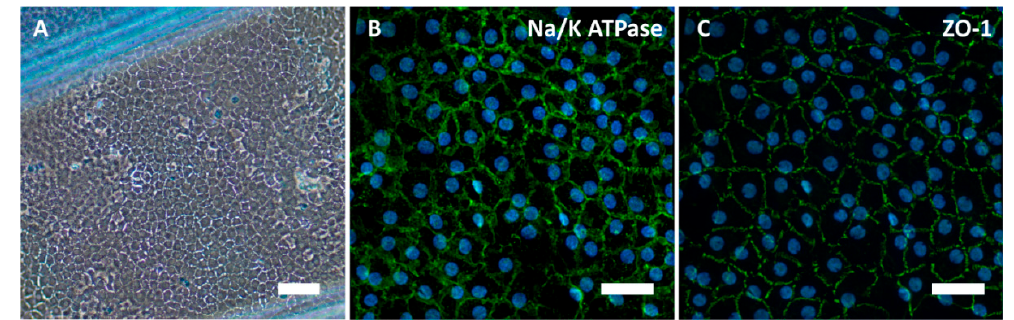
Figure 2. Human corneal endothelium biopsy analysis. Brightfield image of the typical hexagonal morphological pattern exhibited by human corneal endothelial cells (hCECs) ( A ); immunofluorescence analysis of native human corneal endothelium ( B and C ); cell nuclei were stained with Hoechst and are shown in blue. Functional marker Na + /K + -ATPase ( B ) and tight junction marker ZO-1 ( C ) are shown in green. Scale bars: ( A ): 100 µ m; ( B ) and ( C ): 50 µ m.